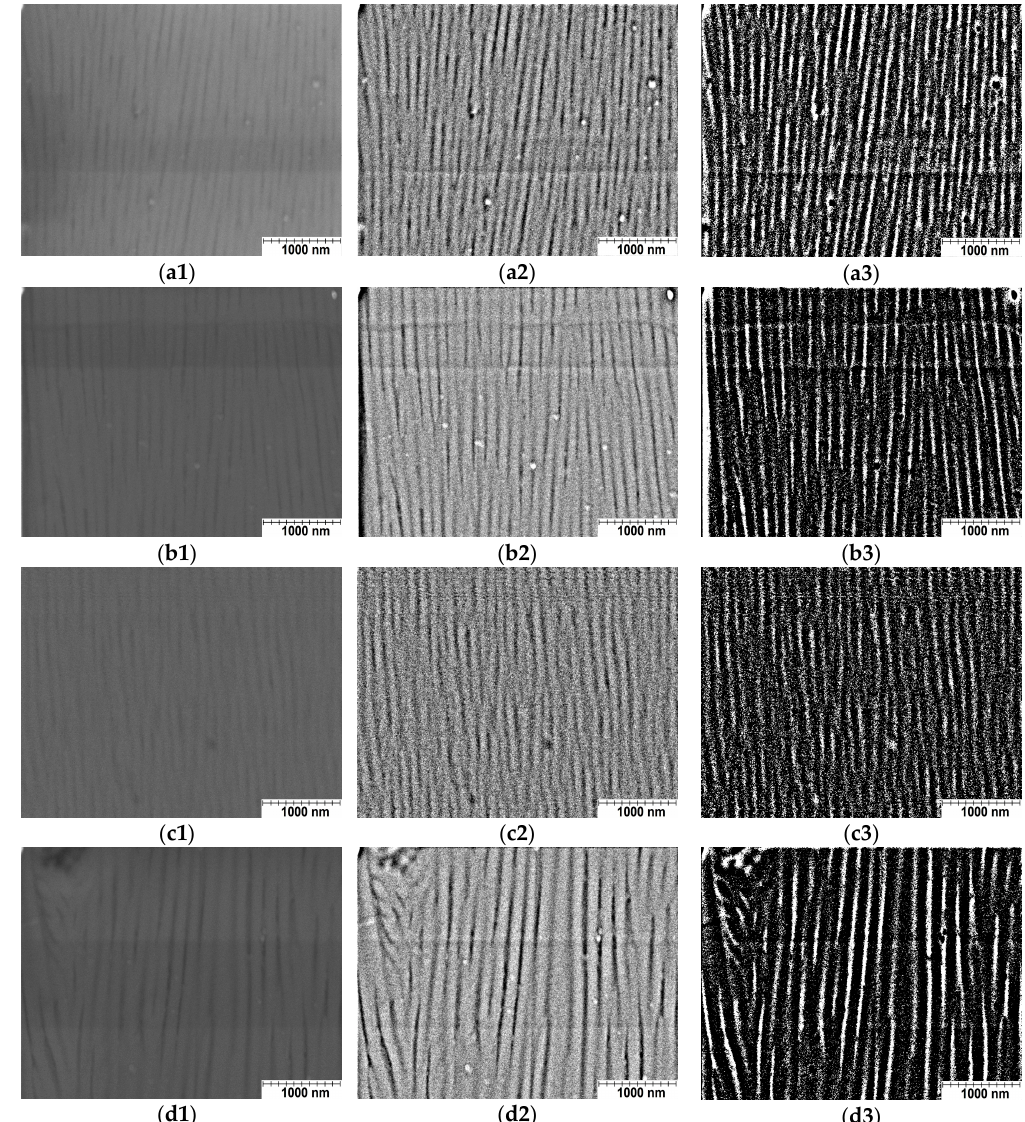
Figure 2. SEM micrograph (cross-section) of nanostructure of the coatings: ( a ) Sample A, ( b ) Sample B, ( c ) Sample C, ( d ) Sample D (sample designations as in Table 2), 1—image with smooth function, 2—image with bandpass filter function, 3—image with threshold function with dark back option selected. The obtained results of the values of the aluminum oxide fiber diameters and the number of fibers on length 1 × 10 3 nm are presented in Table 4. Average values of diameters and number of coating fibers.